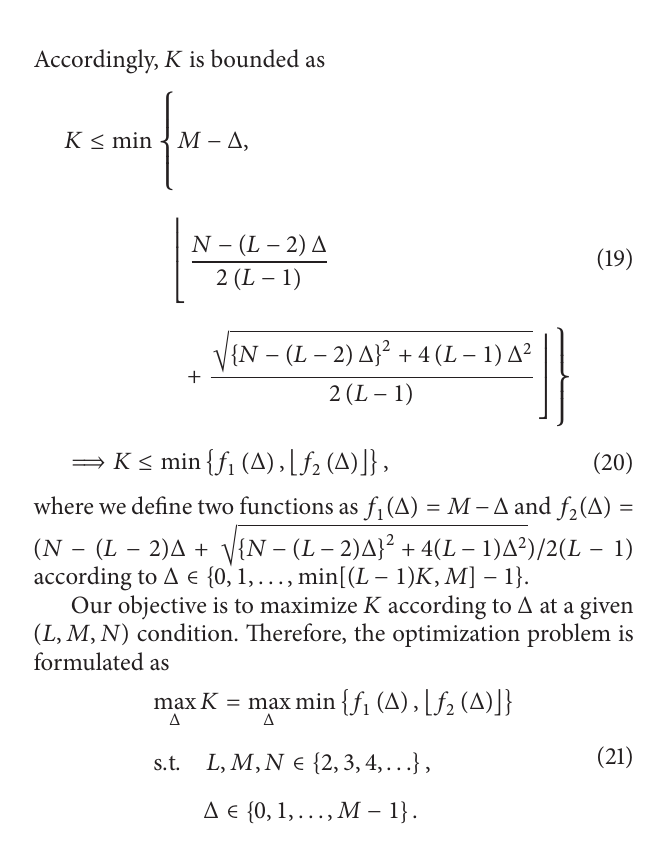
Figure 2: Proposed IA scheme for (𝐿,𝐾,𝑀,𝑁) = (3,2,3,5)